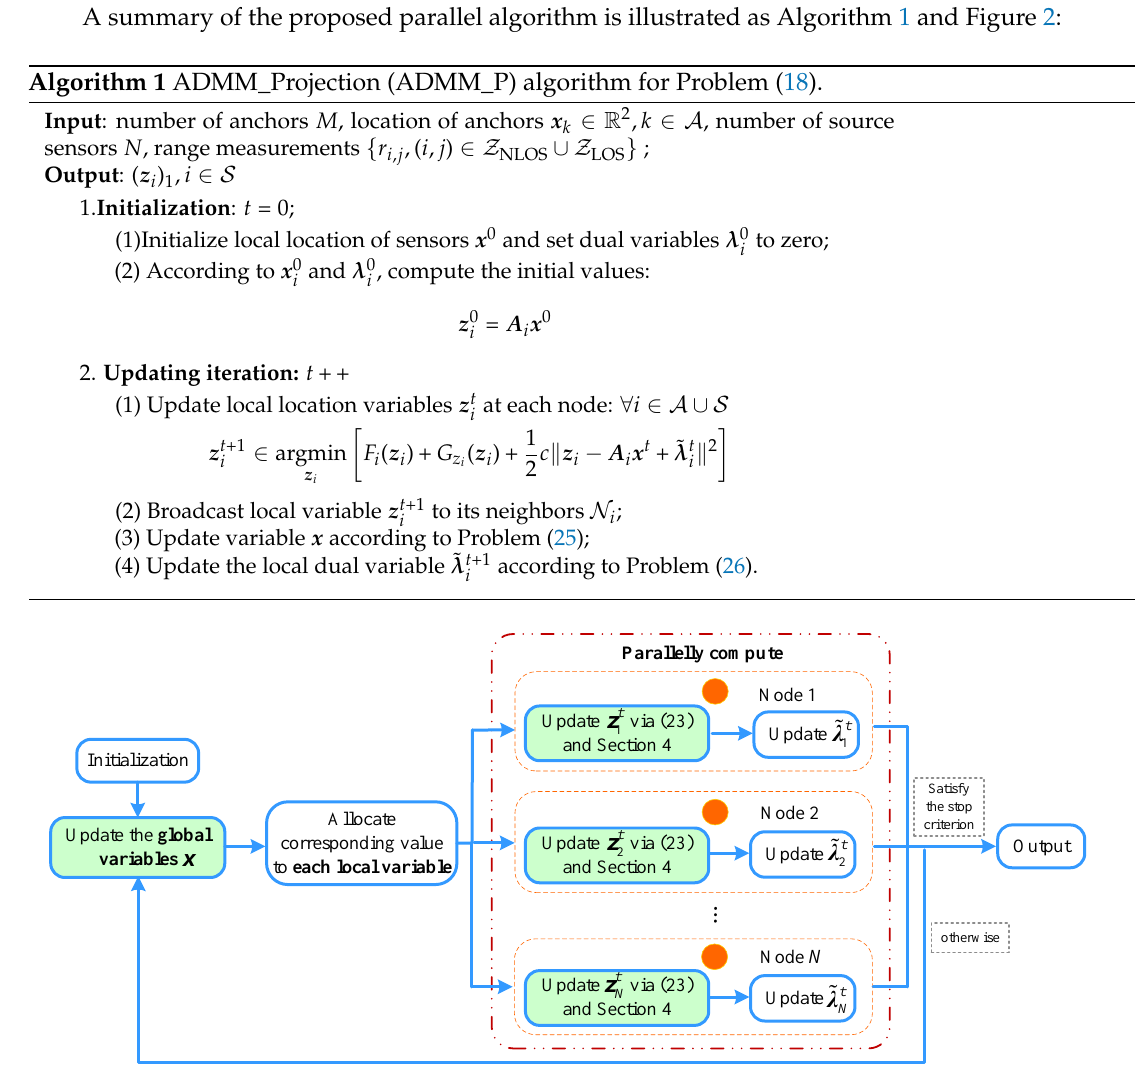
Figure 2. Flow chart of the ADMM_P